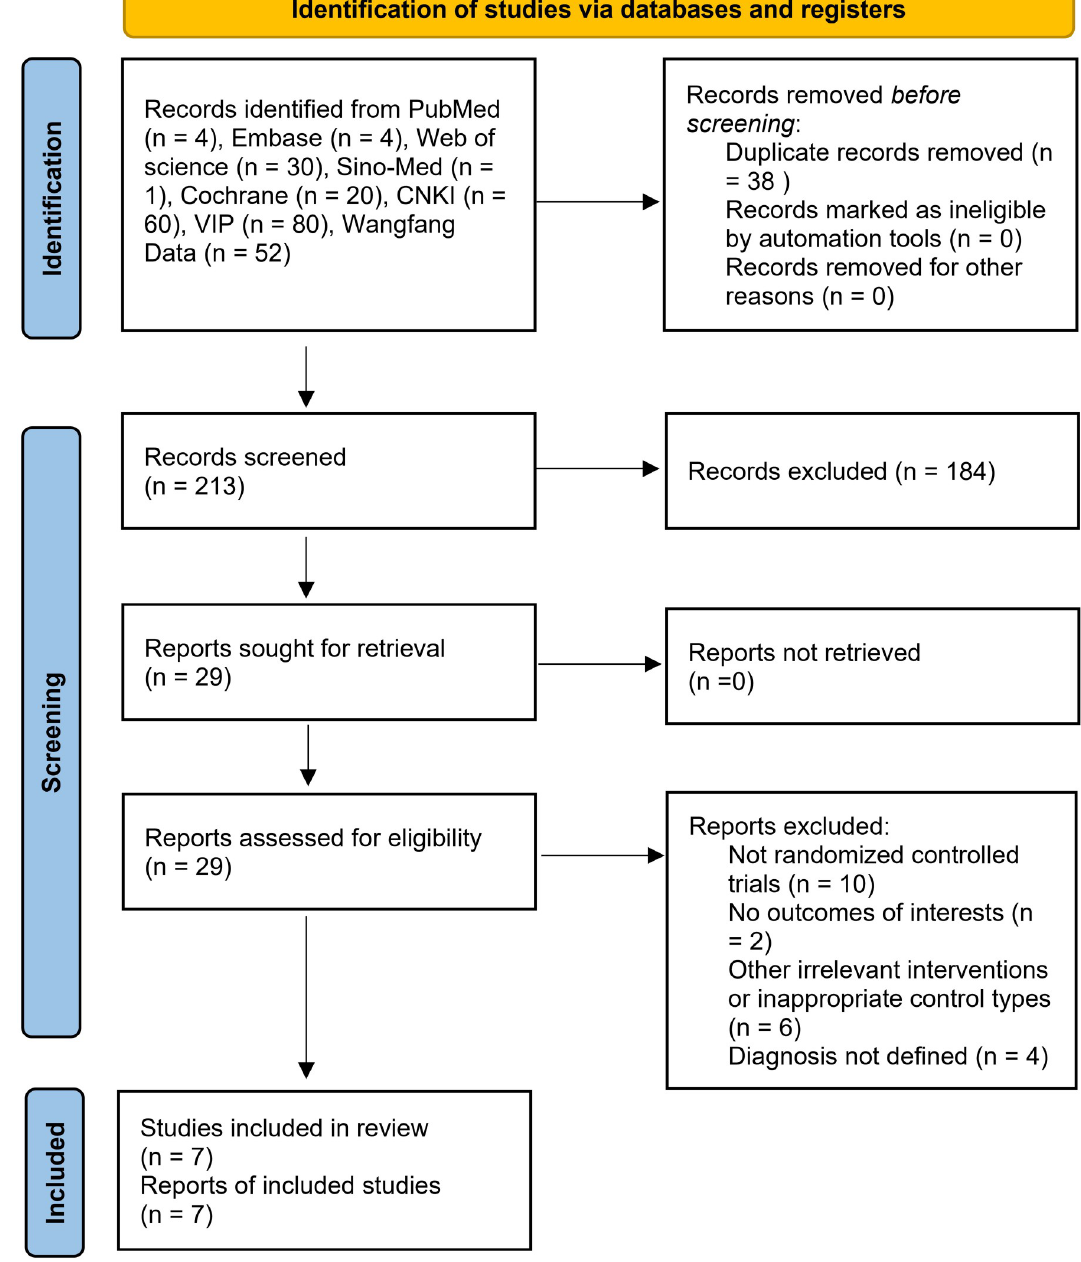
Fig 1. PRISMA flow chart of study selection in this review. CNKI: China National Knowledge Infrastructure. VIP: China Science and Technology Journal Database.